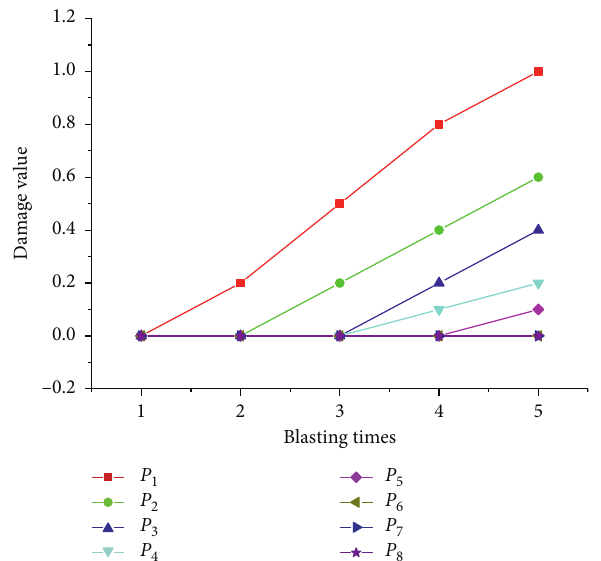
Figure 13: The curve of the relationship between cumulative damage of rock anchor beam monitoring points perpendicular to the axis of powerhouse and blasting